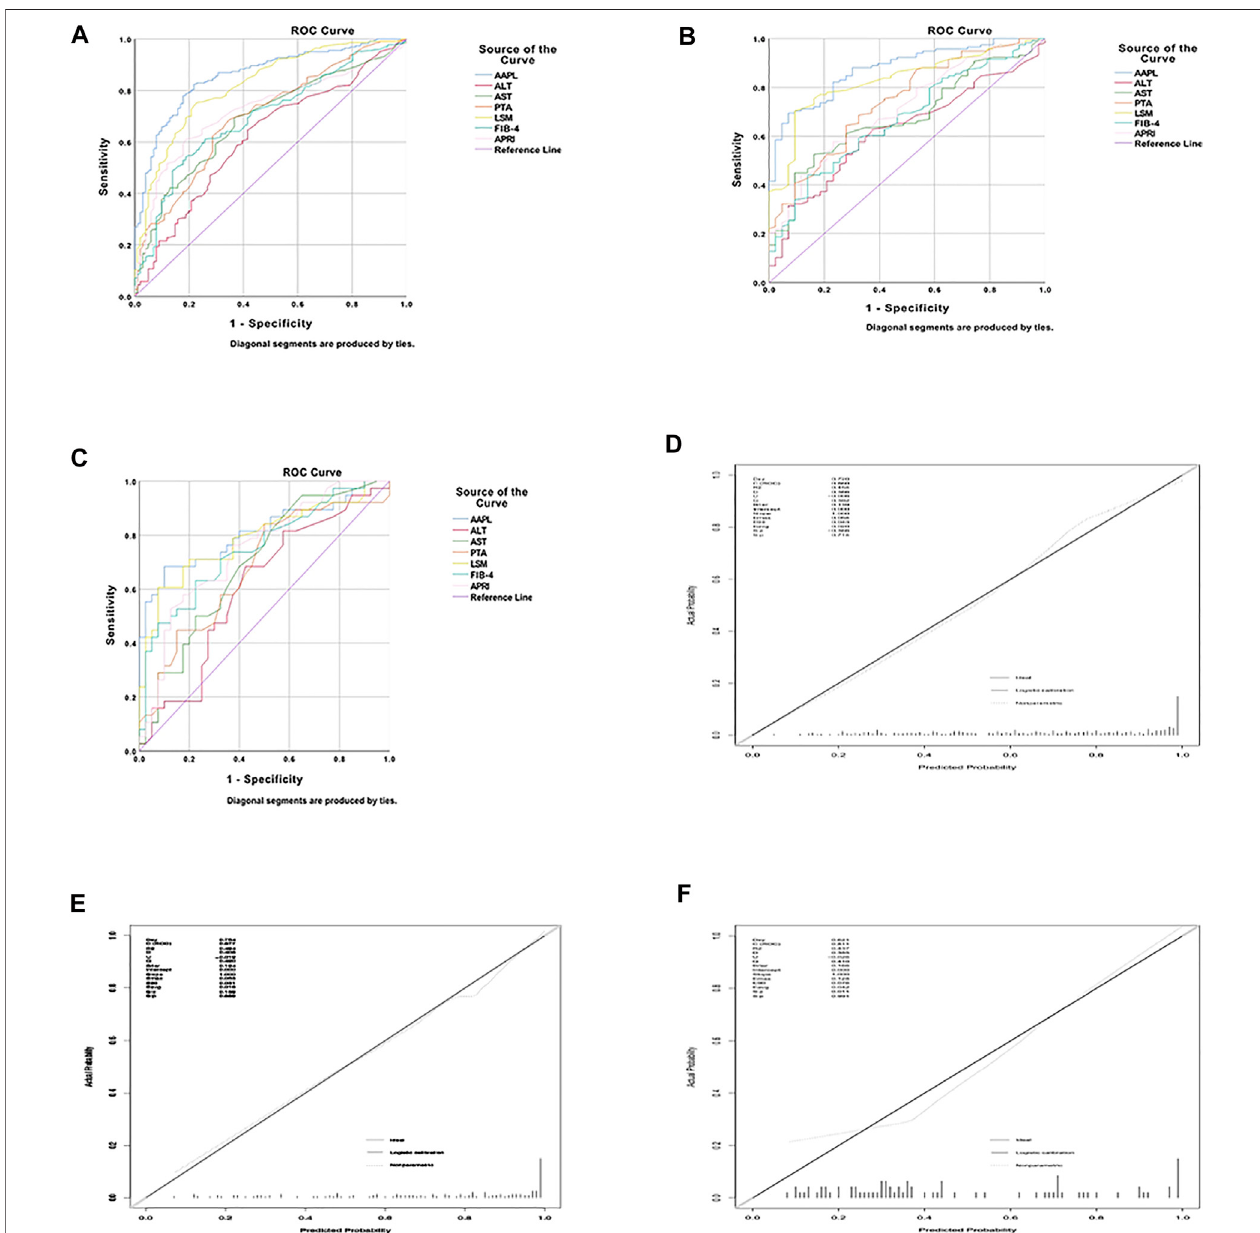
FIGURE2| Theareaunderthereceiveroperatingcharacteristic(AUROC)curveandcalibrationcurvefortheAAPLnomogram(ALT,AST,PTA,andLSM).AUROC values of the AAPL nomogram for predicting signi fi cant fi brosis in patients with CHB in the (A) development cohort (AUROC (cid:1) 0.86), (B) internal validation cohort (AUROC (cid:1) 0.877), and (C) independent validation cohort (AUROC (cid:1) 0.811). Calibration curve of the AAPL nomogram for predicting signi fi cant fi brosis in patients with CHB in the (D) development cohort, (E) internal validation cohort, and (F) independent validation cohort.